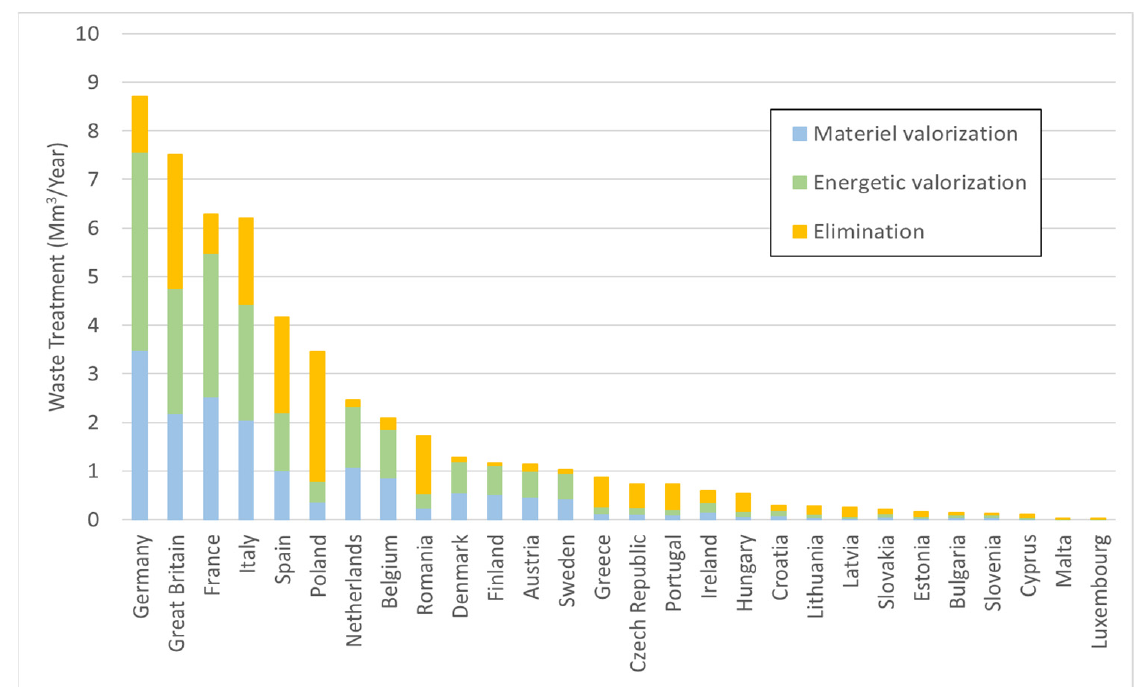
Figure 2. Wood waste volumes and handling methods in Europe. Drawn from [4].